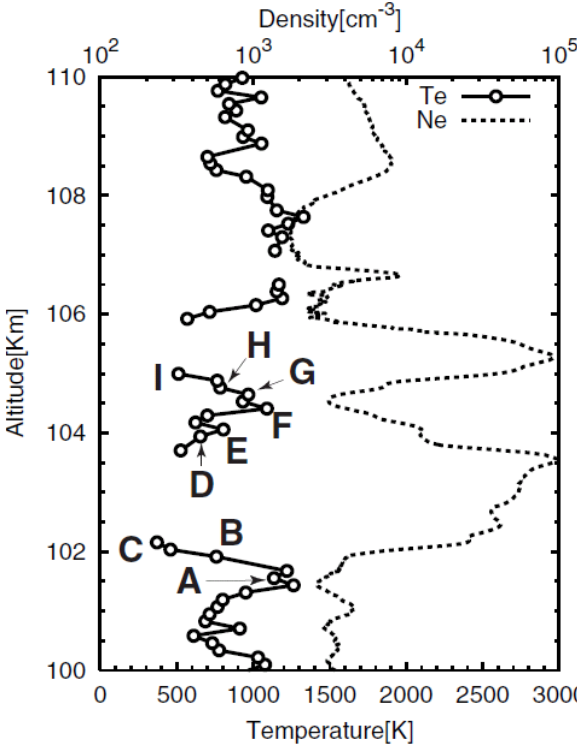
Fig. 5. T e (solid line with white circles) and N e (dashed line) in the height range of 100–110km. The heights indicated by A, B, C, D, E, F, G, and I show the heights where v-i characteristics curves and semi-log plotted curves of electron current, shown in Fig. 4, were measured. N e and T e below the height of 100km are not shown here, in order to show the better fine height profile by reducing the height range.